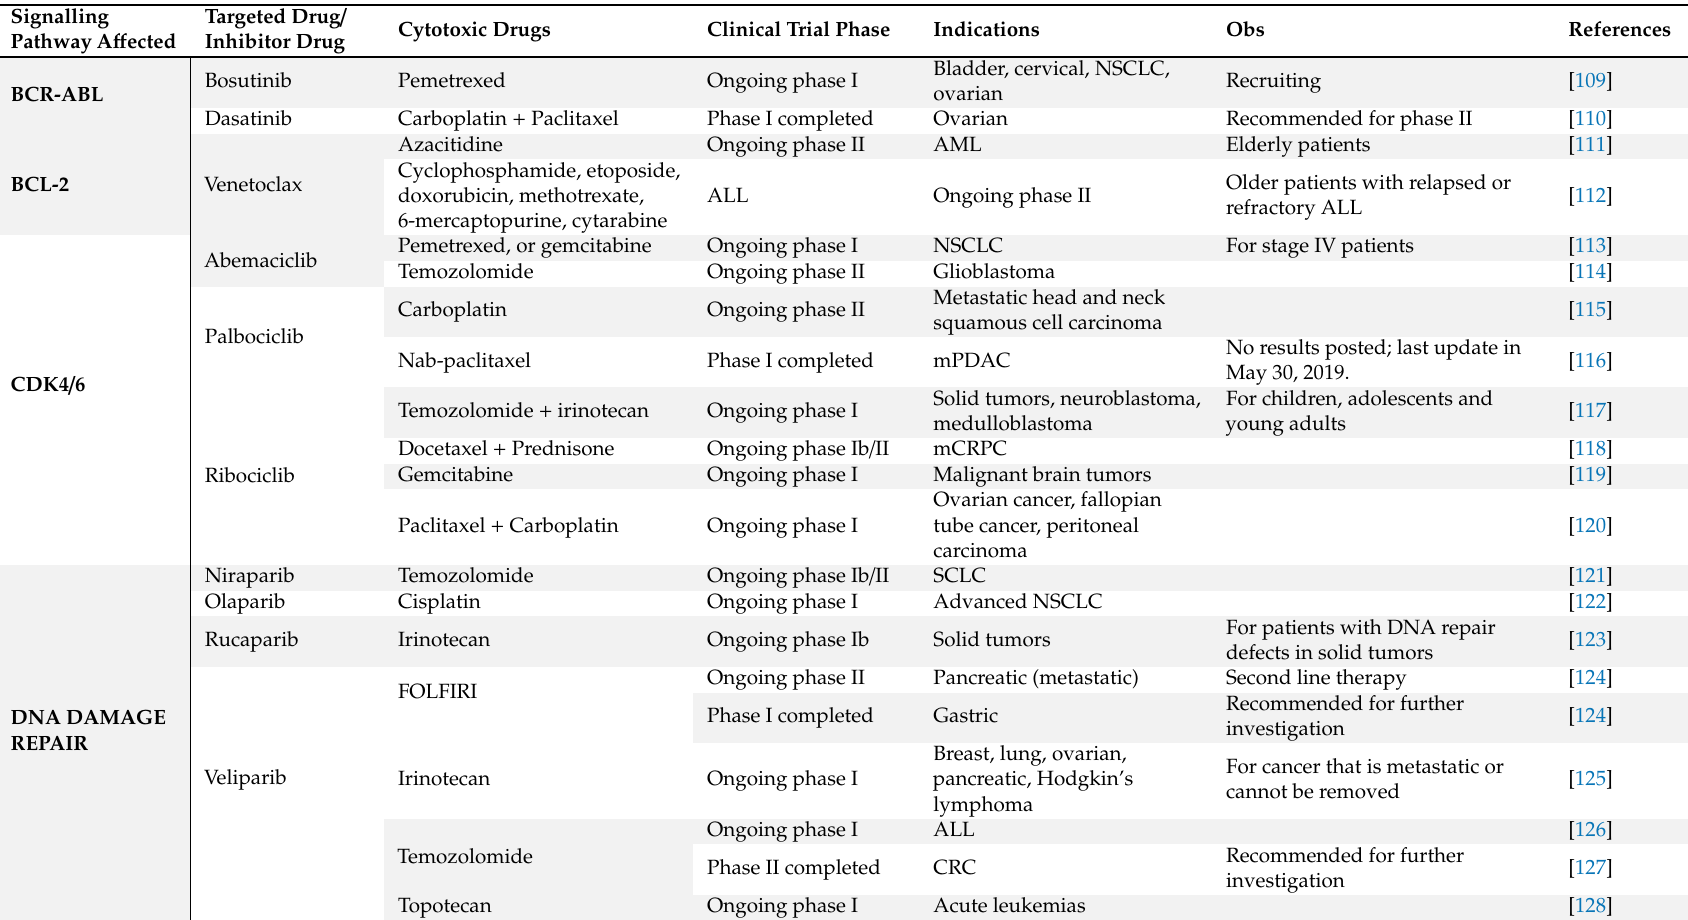
Table 3. Clinical trials with combinations in which targeted therapies inhibit resistance mechanisms of cytotoxic drugs.